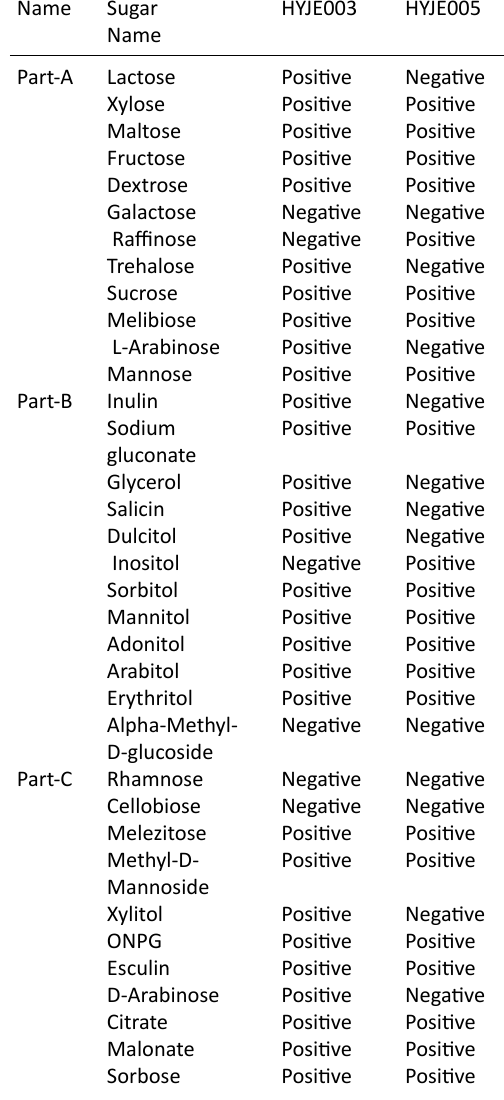
Table 3. Hi-Carbohydrate kit result for isolated